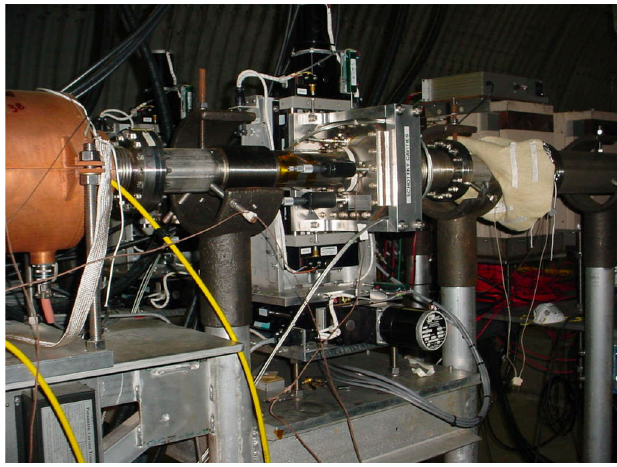
FIG. 1. (Color) High frequency Schottky cavity detector in the RHIC